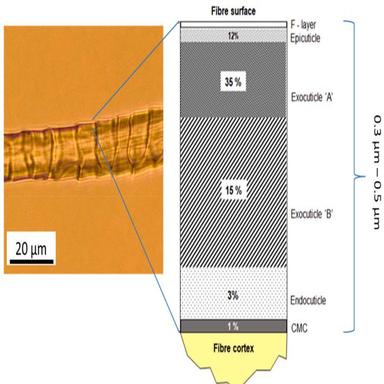
Surface of a merino wool fibre with cuticle cells covering the fibre surface (left) and schematic drawing of a wool fibre cuticle (left).